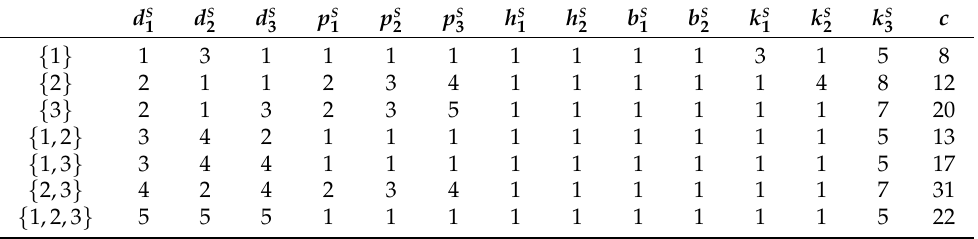
Table 3. SI-situation with three periods and three players with the associated